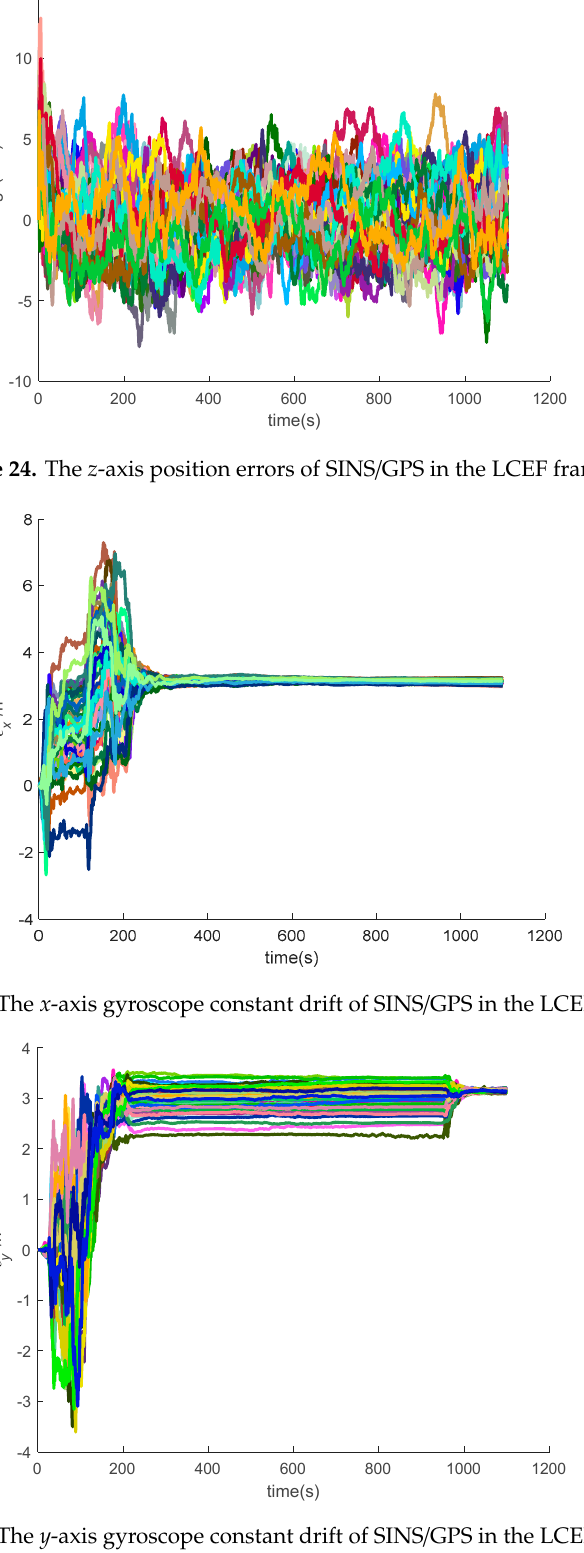
Figure 27. The z -axis gyroscope constant drift of SINS/GPS in the LCEF frame.